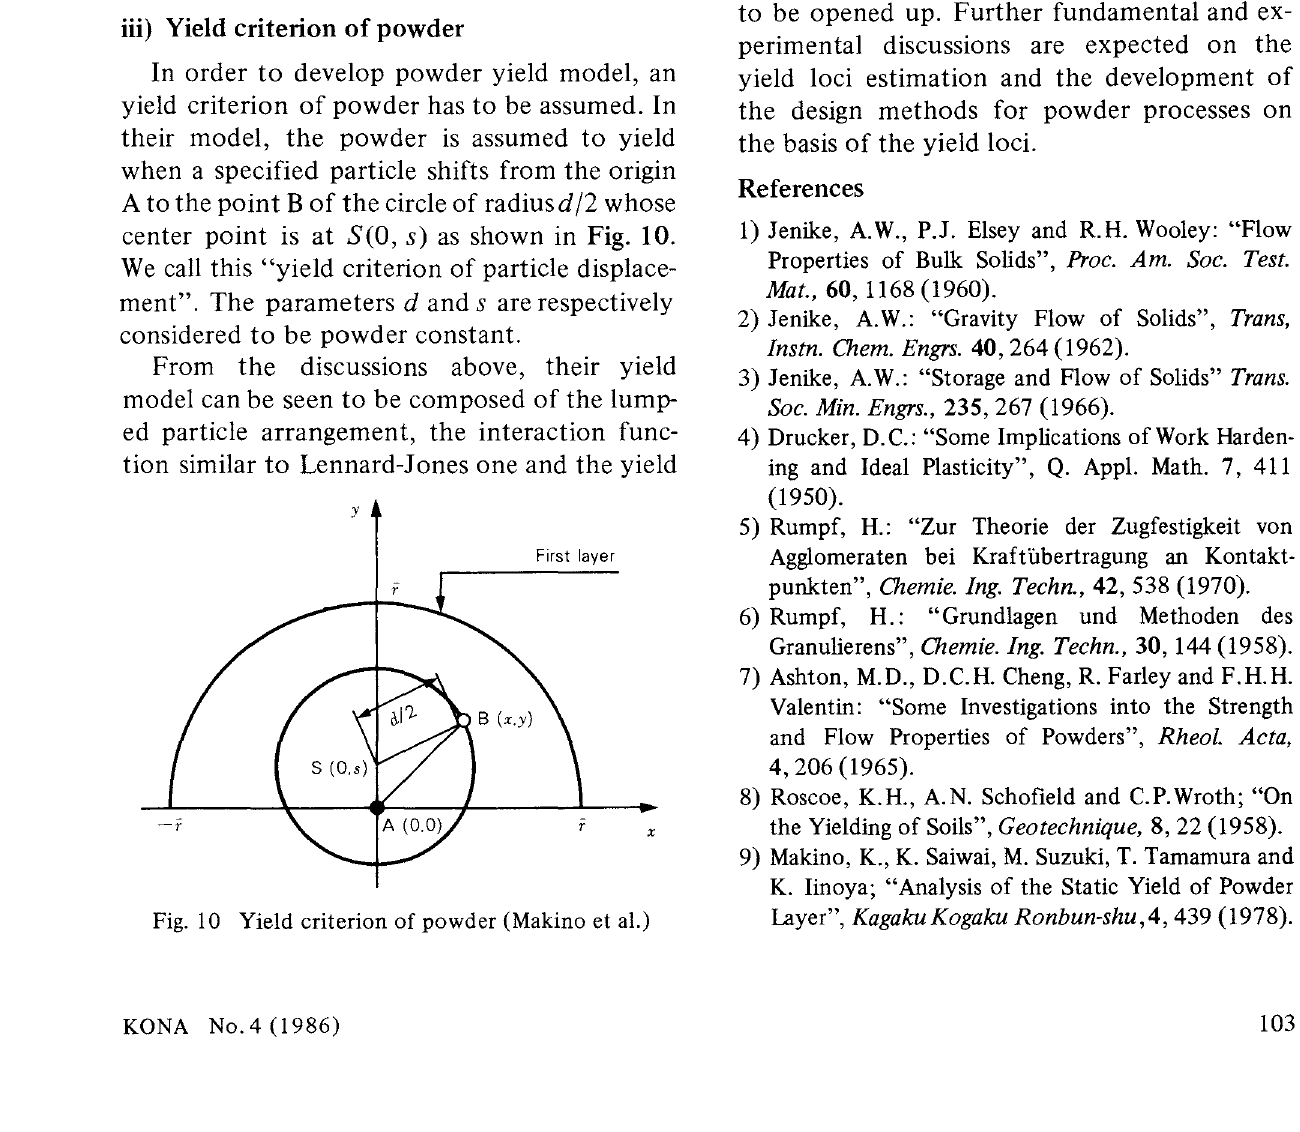
Fig. 10 Yield criterion of powder (Makino et